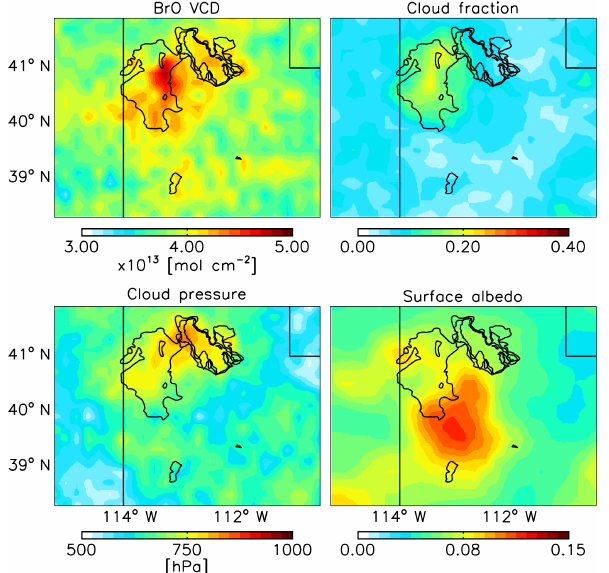
Figure 11. Mean June 2006 BrO VCD over the Great Salt Lake area. Averages have been calculated on a 0.2 ◦ × 0.2 ◦ grid includ- ing only pixels with cloud fractions smaller than 0.4. The straight lines are borders of the state of Utah, and the curving lines represent the Great Salt Lake (eastern oval area) and Salt Flats (western oval area).